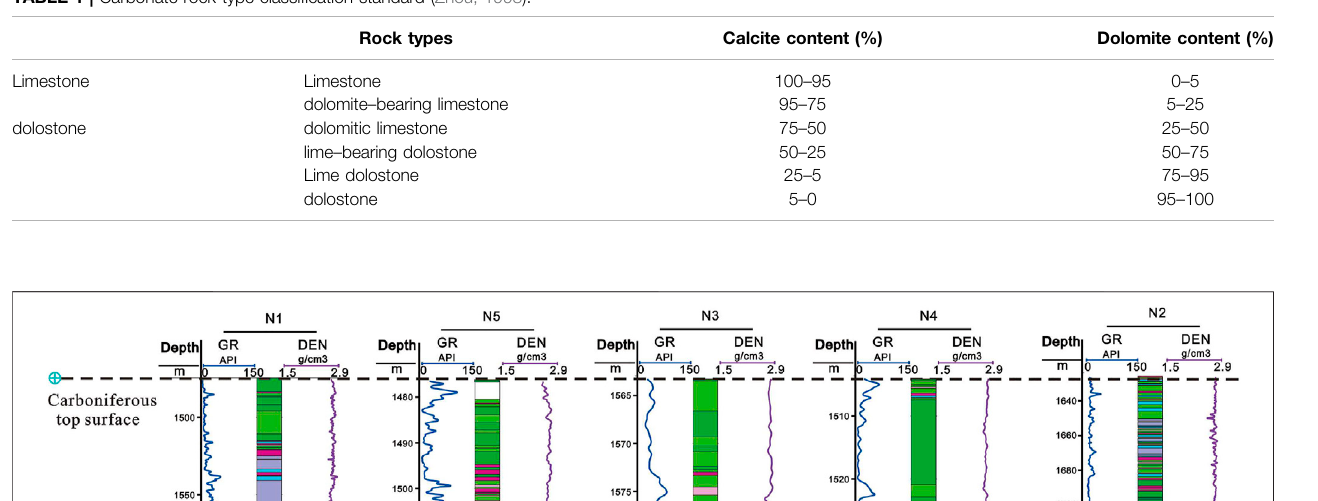
Frontiers in Earth Science |